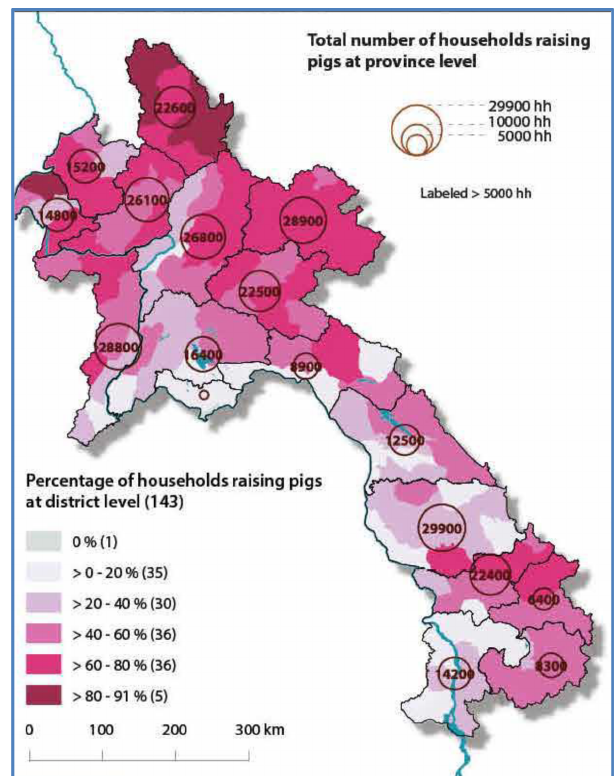
Figure 1. Map of the survey area; Epprecht et al. (2018), CC BY